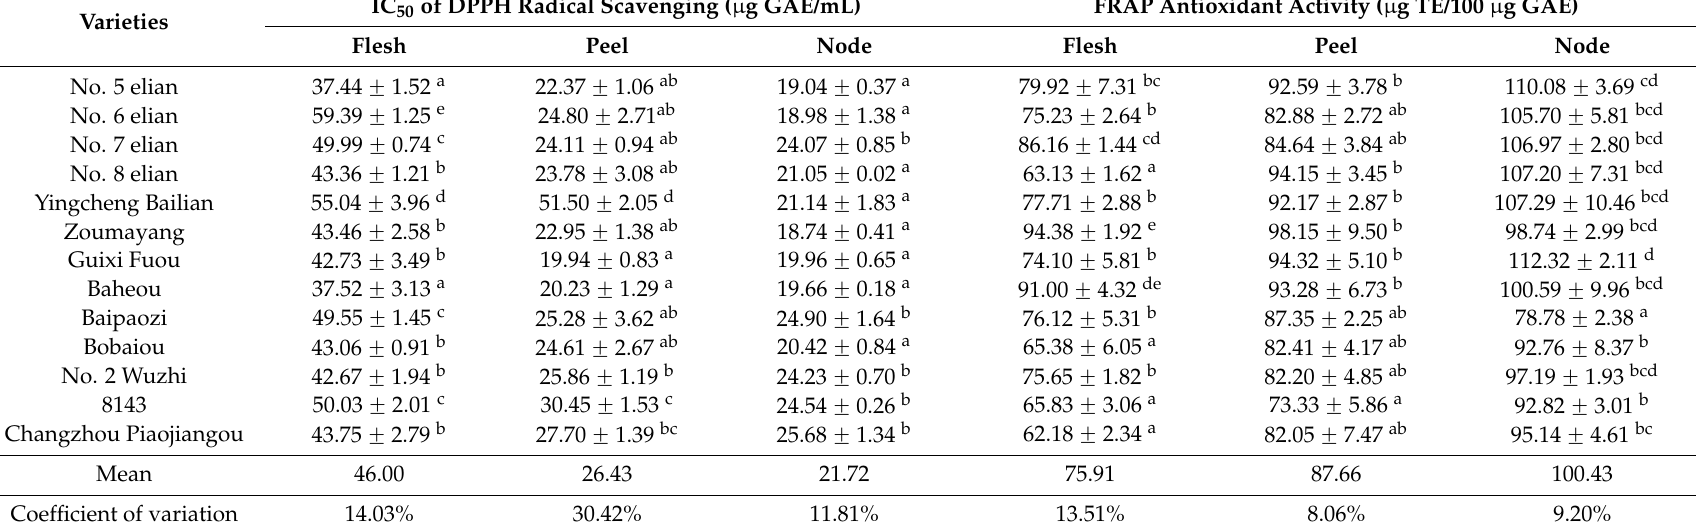
Table 5. Antioxidant activities of phenolic compounds from the different parts of lotus root varieties.